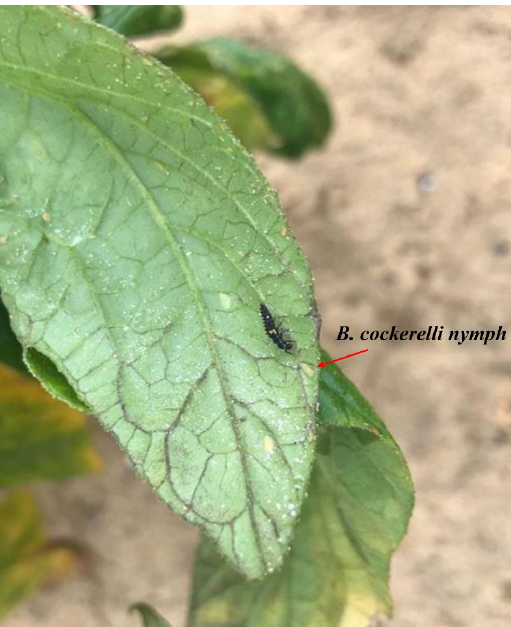
Figure 1. Coccinella transversalis larvae praying on Bactericera cockerelli nymphs on capsicum in the field.